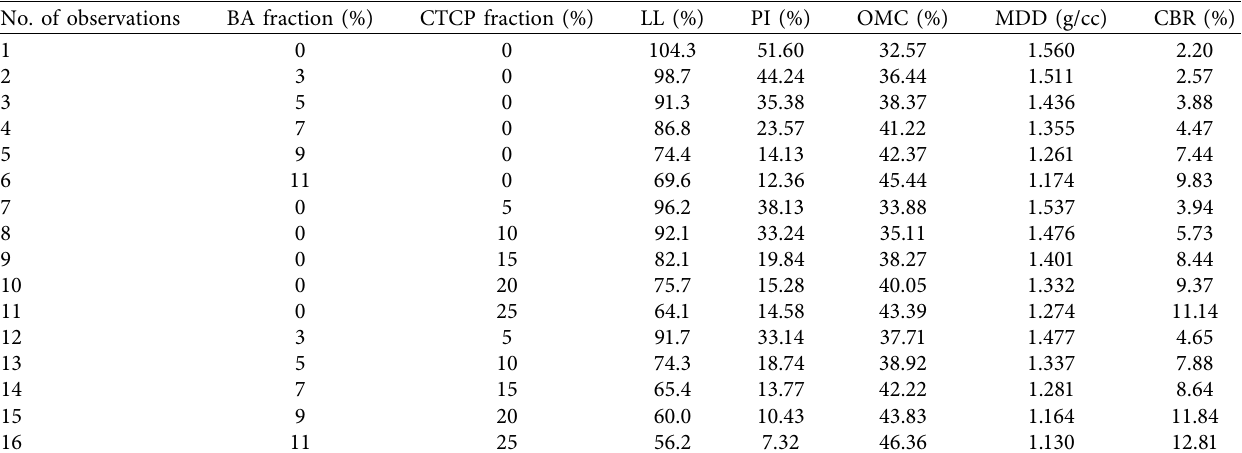
Figure 20: SEM images of the (soil+9% BA +20% CTCP) at different sizes and magnification rates. (a) 50 µ m, × 500. (b) 10 µ m, × 2000. Table 10: Experimental results of the BA and CTCP stabilized soil.